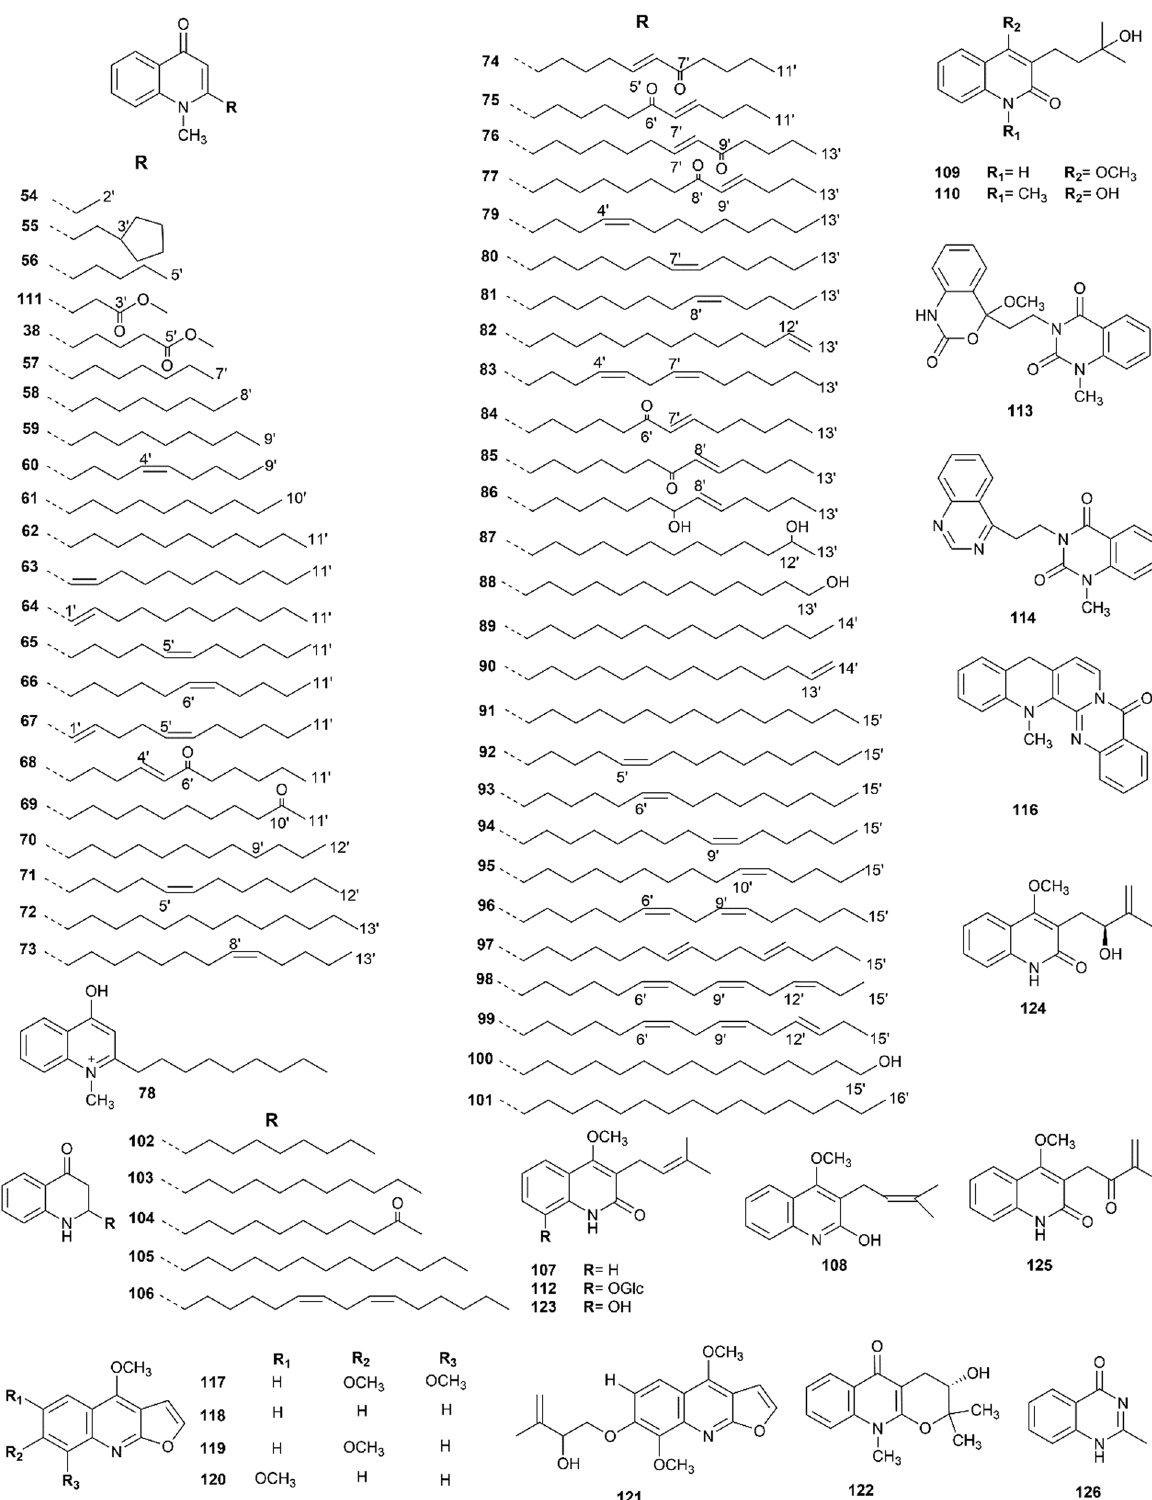
Fig. 3 Quinoline alkaloids isolated from Euodiae